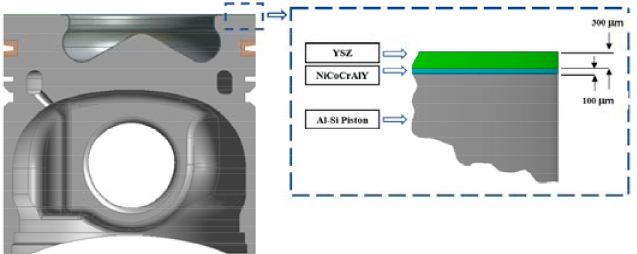
Figure 5. The half piston model and thermal barrier coating thickness.